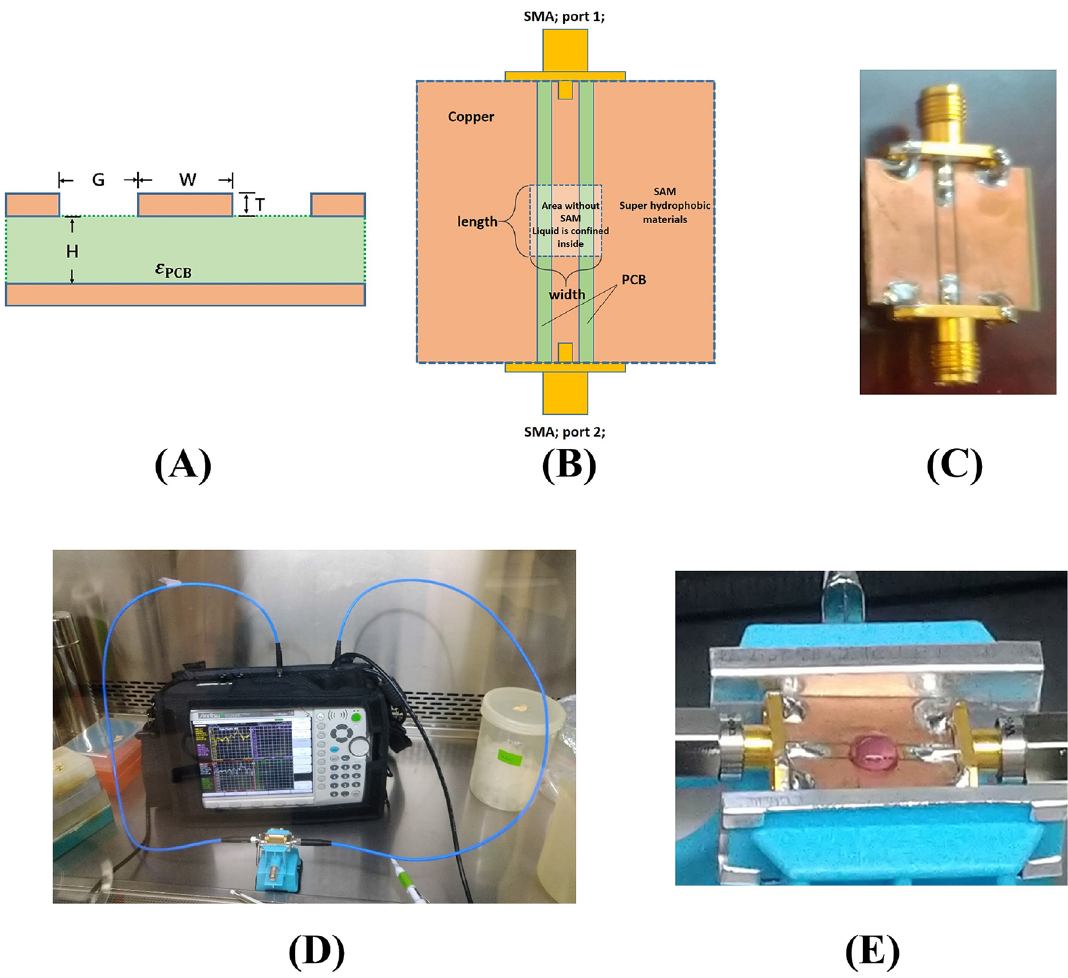
Figure 1. ( A ) Schematic showing the cross-section of the coplanar waveguide. ( B ) Schematic showing the design of the CPW with self-assembled monolayer mask on top to expose the gap and the signal line. ( C ) CPW with hydrophobic SAM mask before connecting to the VNA. ( D ) Microwave absorption measurement system set up in a biological safety cabinet in BSL-2 laboratory. ( E ) 40 µL DMEM medium droplet with coronavirus confined inside the SAM